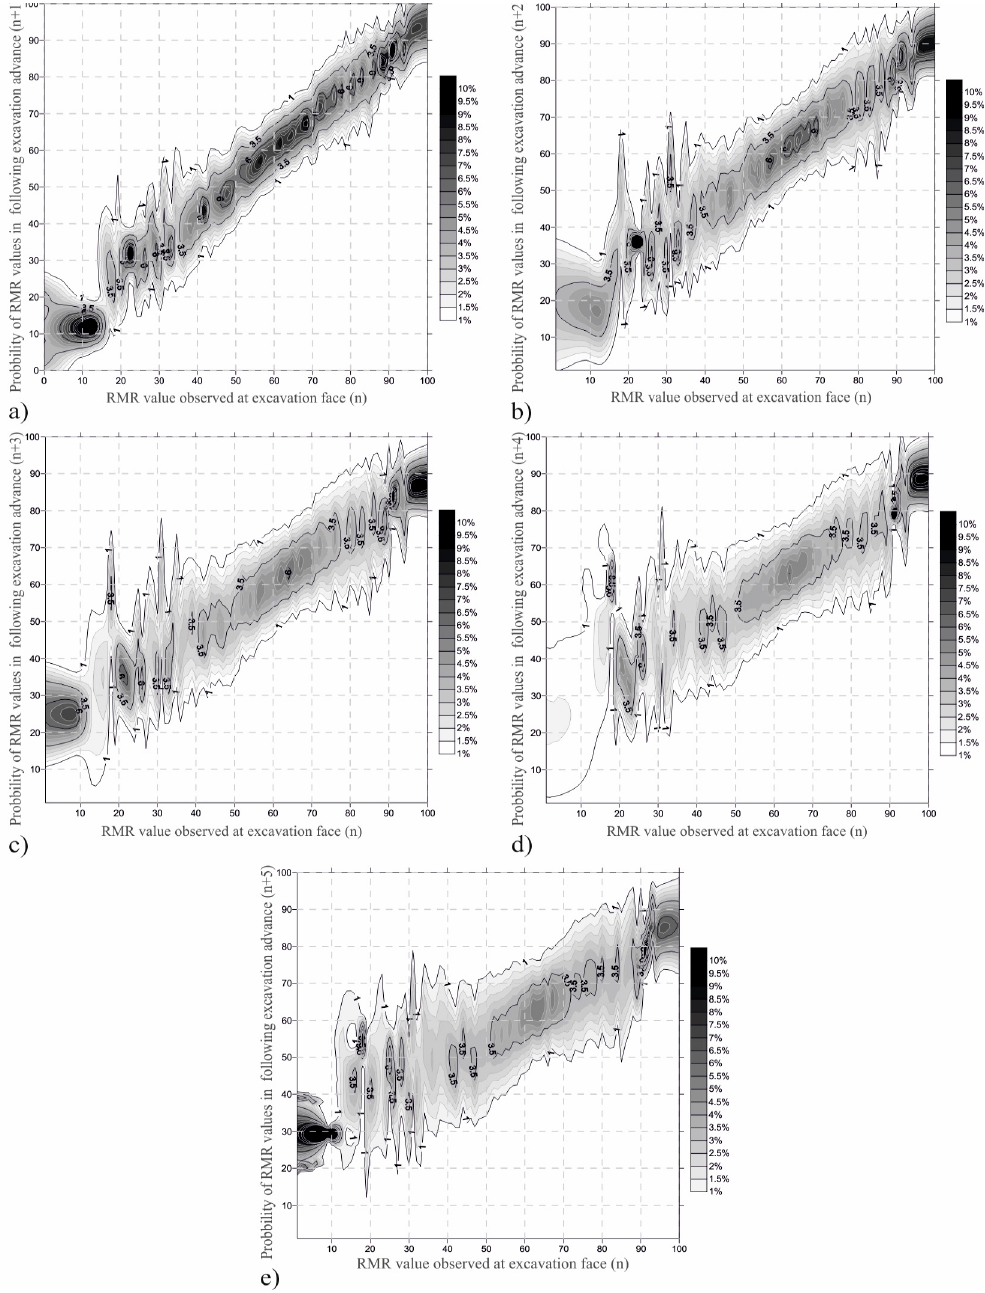
Figure 9. Probability of occurrence of RMR values on the following fronts according to that observed at the current face ( n ): ( a ) for the n + 1 excavation advance; ( b ) for the n + 2 excavation advance; ( c ) for the n + 3 excavation advance; ( d ) for the n + 4 excavation advance; and, ( e ) for the n + 5 excavation advance.